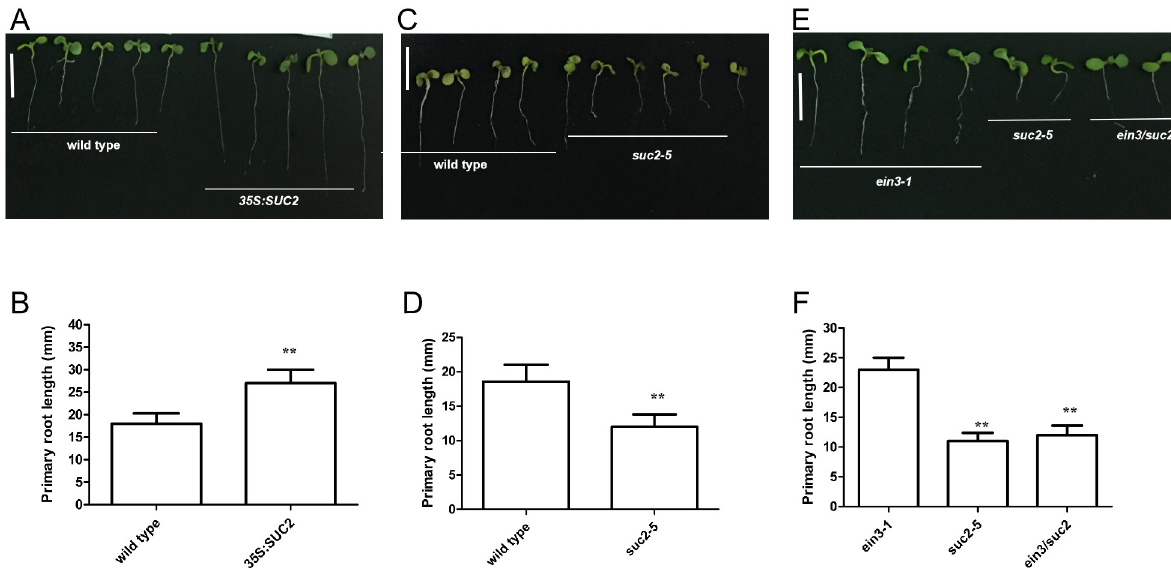
Fig 5. SUC2 is downstream of EIN3 to positively regulate primary root growth. A , Image illustrating the 5-day-old Arabidopsis wild-type and 35S : SUC2 seedlings grown on MS medium with 1% glucose. Bar = 1.0 cm. B , Bar graph illustrating the differences in primary root length in (A). C , Image illustrating the 5-day-old wild-type and suc2-5 seedlings grown on MS medium with 1% glucose. Bar = 1.0 cm. D , Bar graph illustrating the differences in primary root length in (C). E , Image illustrating the 5-day-old ein3-1 , suc2-5 and ein3/suc2 seedlings grown on MS medium with 1% glucose. Bar = 1.0 cm. F , Bar graph illustrating the differences in primary root length in (E). Error bars represent SD (n = 14). Student’s t test ( �� P <